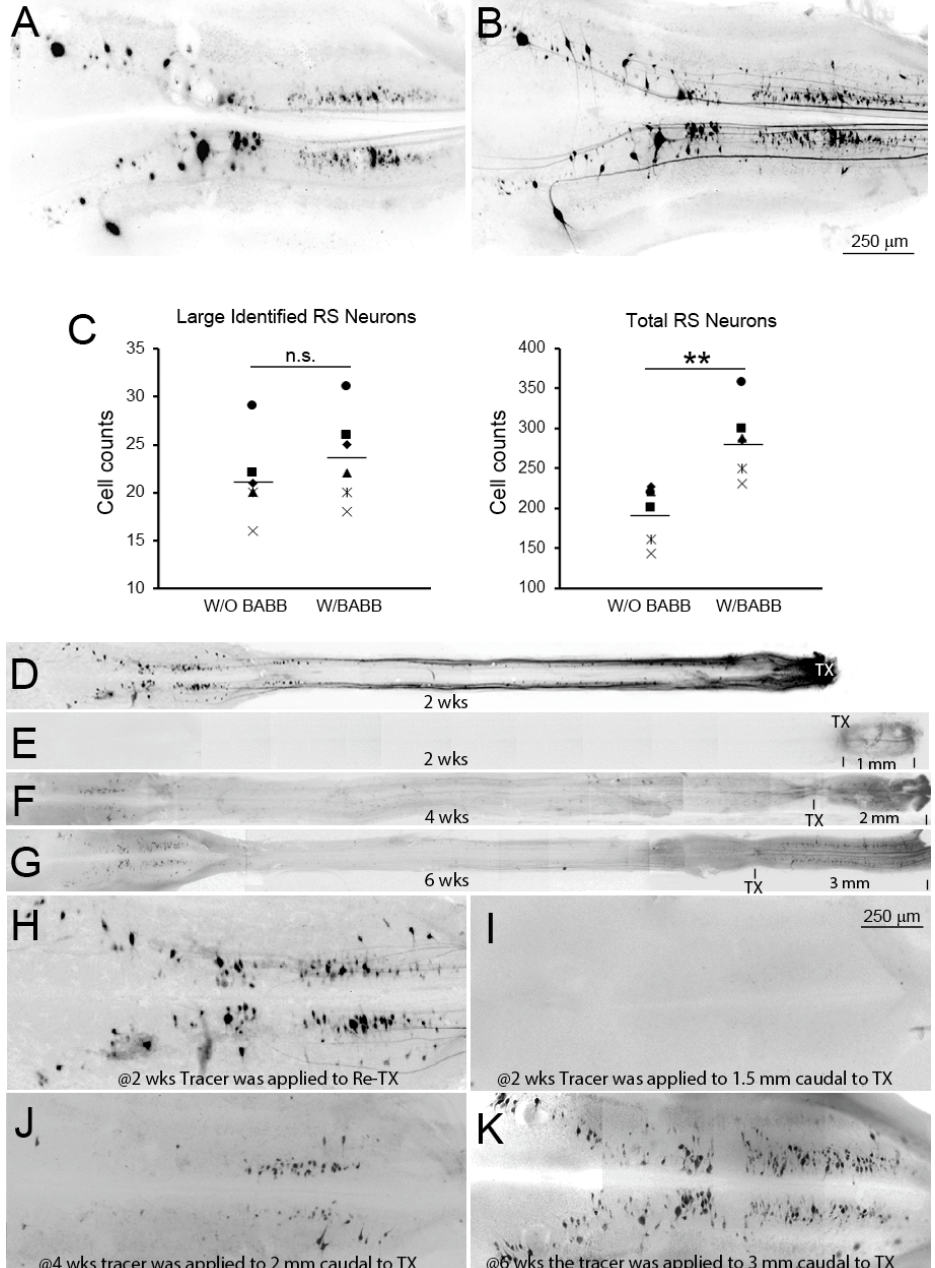
Figure 6. BABB clearing increases the apparent number of neurons with regenerated axons. In 6 animals at 13 wks post-TX, RS neurons with regenerated axons were retrogradely labeled with